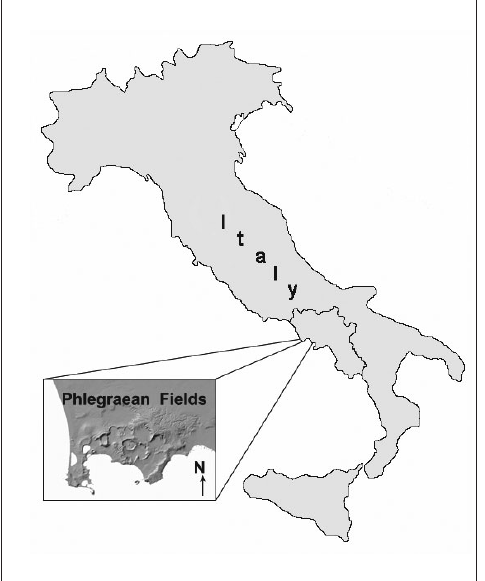
Fig. 1. Location of the volcanic area.